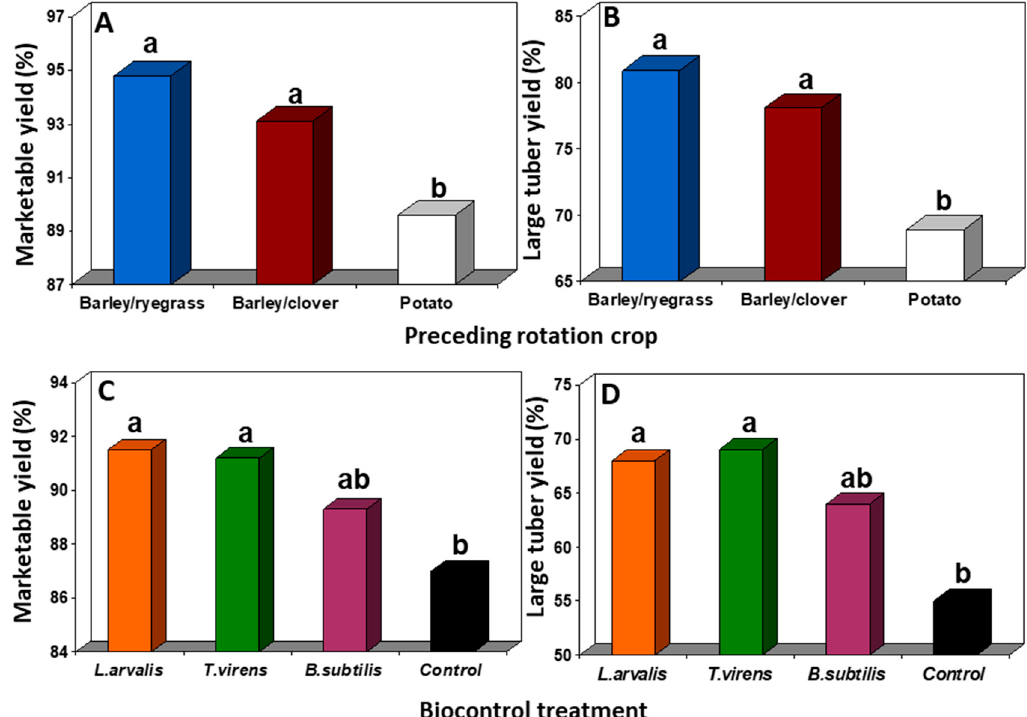
Figure 2. Percent yield for ( A ) marketable tubers and ( B ) large size class tubers by preceding rotation crop at location 1 (Central Maine) and for ( C ) marketable tubers and ( D ) large size class tubers by biocontrol treatment at location 2 (Northern